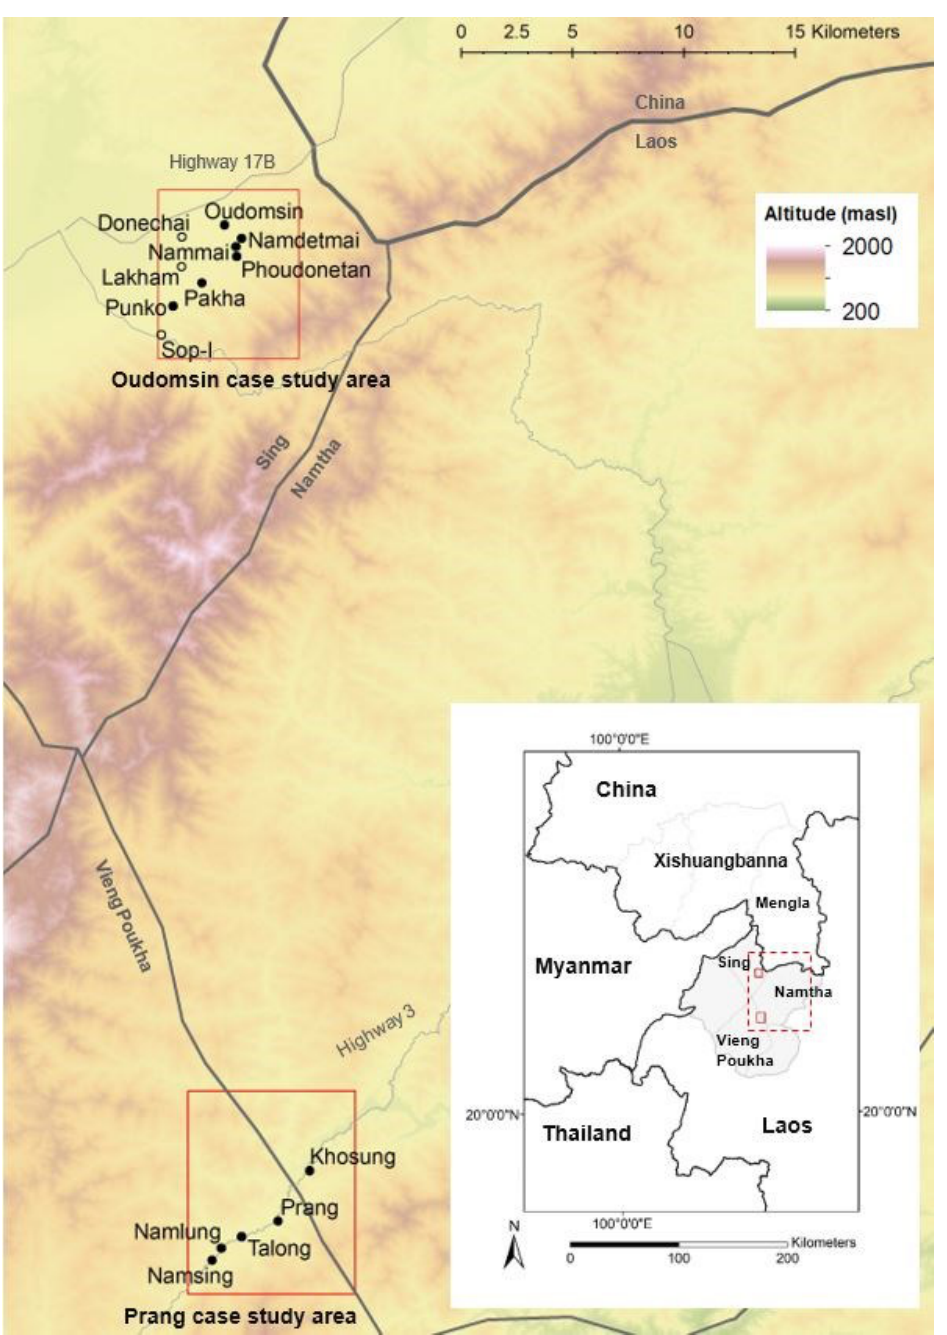
Figure A1.1: Map of the two case study areas and villages studied (solid points). Luang Namtha Province is shaded in gray in the lower